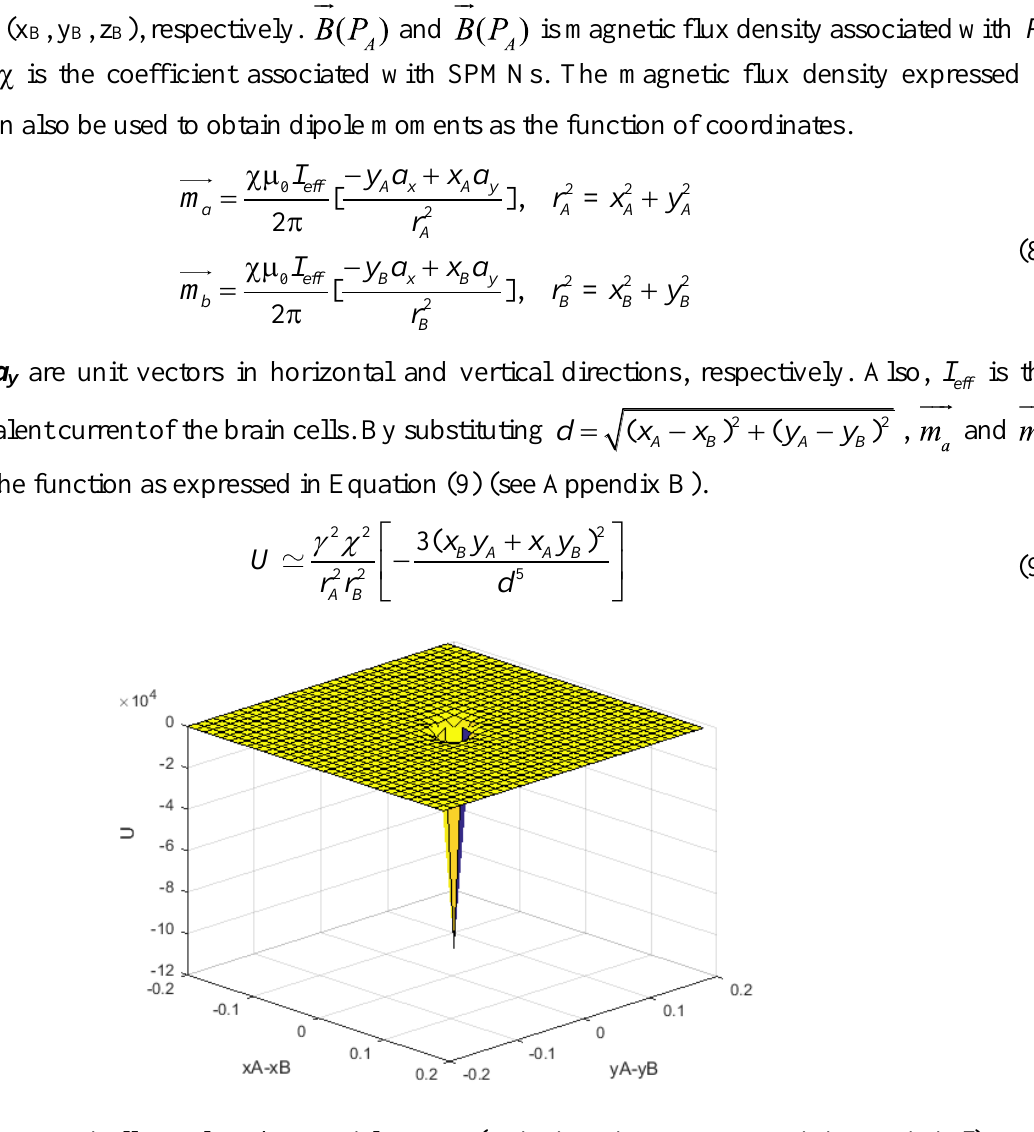
Figure 2. Numerically analyzed potential energy (units in axis x-y are m , unit in z-axis is J